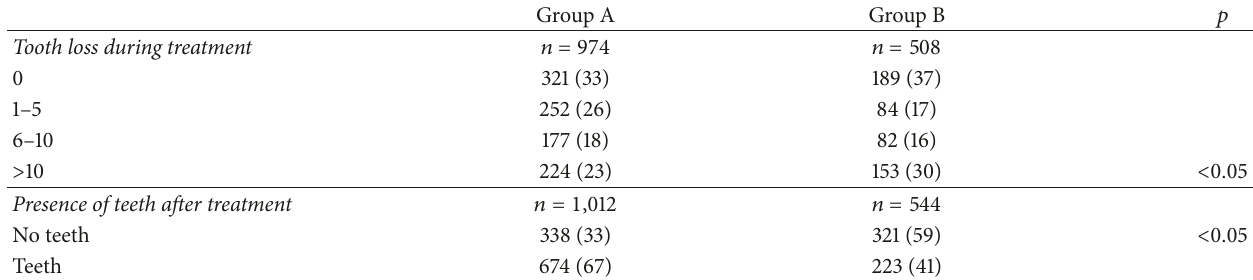
Table 2: Loss of teeth during treatment for oral squamous cell carcinoma in 1,607 patients, compared by frequency of dental visits.